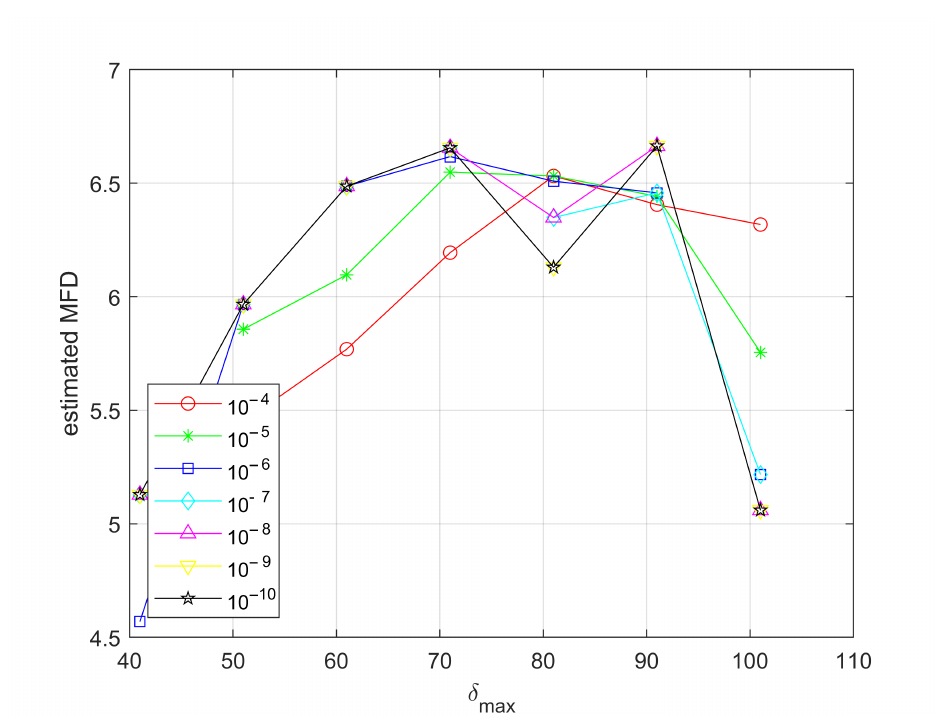
Figure 12. The estimated multi-spectral fractal dimension as a function of δ max for the high generated complexity ( H = 0.1) multi-spectral fractal image.